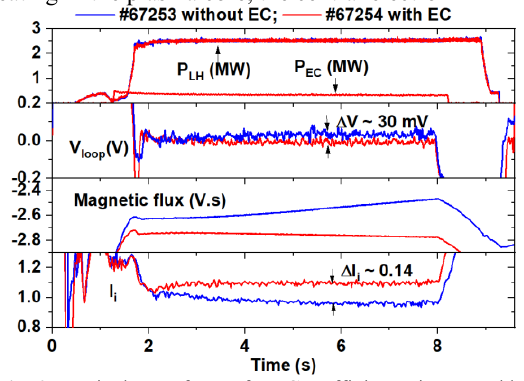
Fig. 9. Typical waveform of LHCD efficiency improved by ECRH.